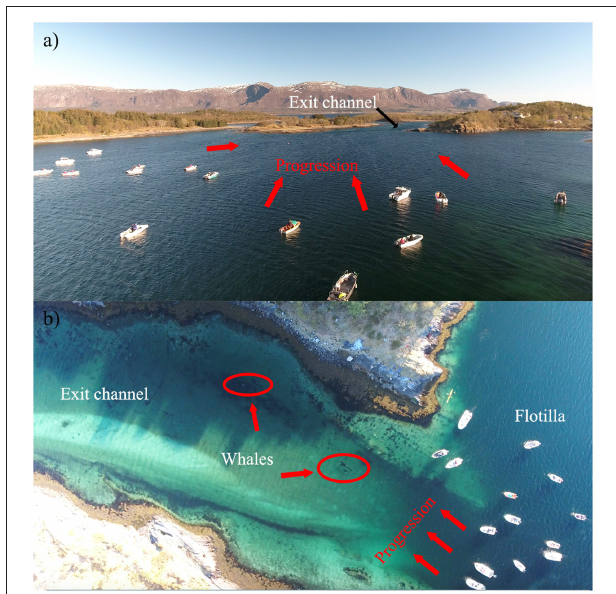
FIGURE 5 | (a) Photograph showing the coordinated line of boats used in Case #17 as a means to guide the entrapped killer whales toward the exit channel; (b) Live aerial imagery (drone), used throughout the intervention in this case (and Case #19), allowed for constant monitoring of behavior (stress, group cohesion) and to carefully adjust the progression of the